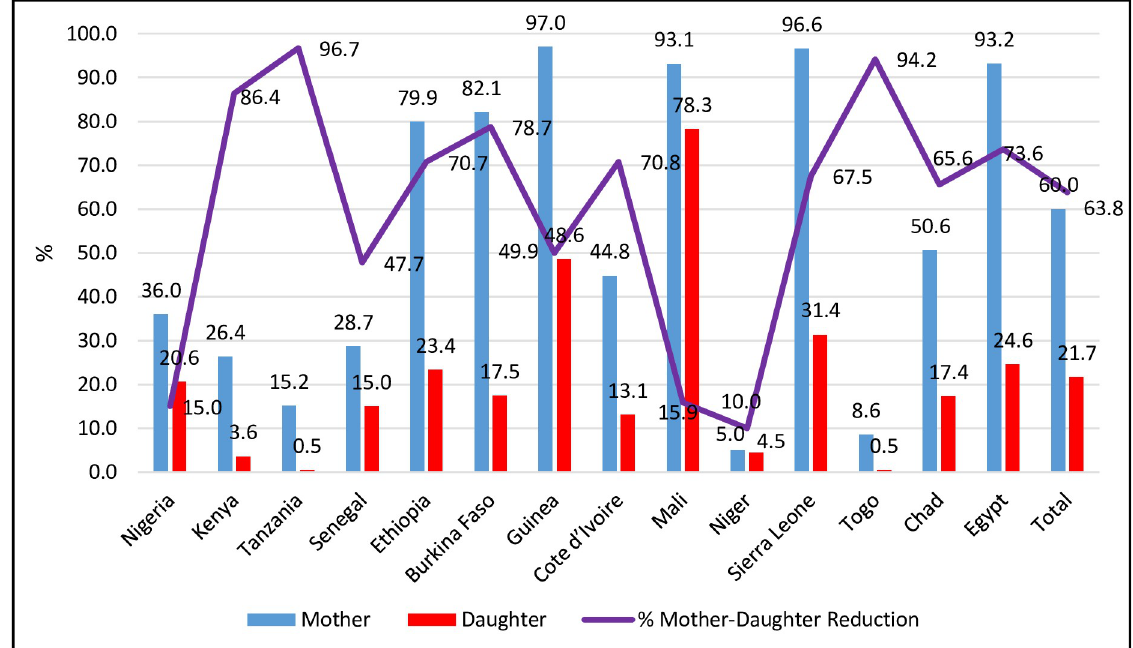
Fig 3. Comparison of the prevalence of FGM among mothers and daughters and the percentage reduction.